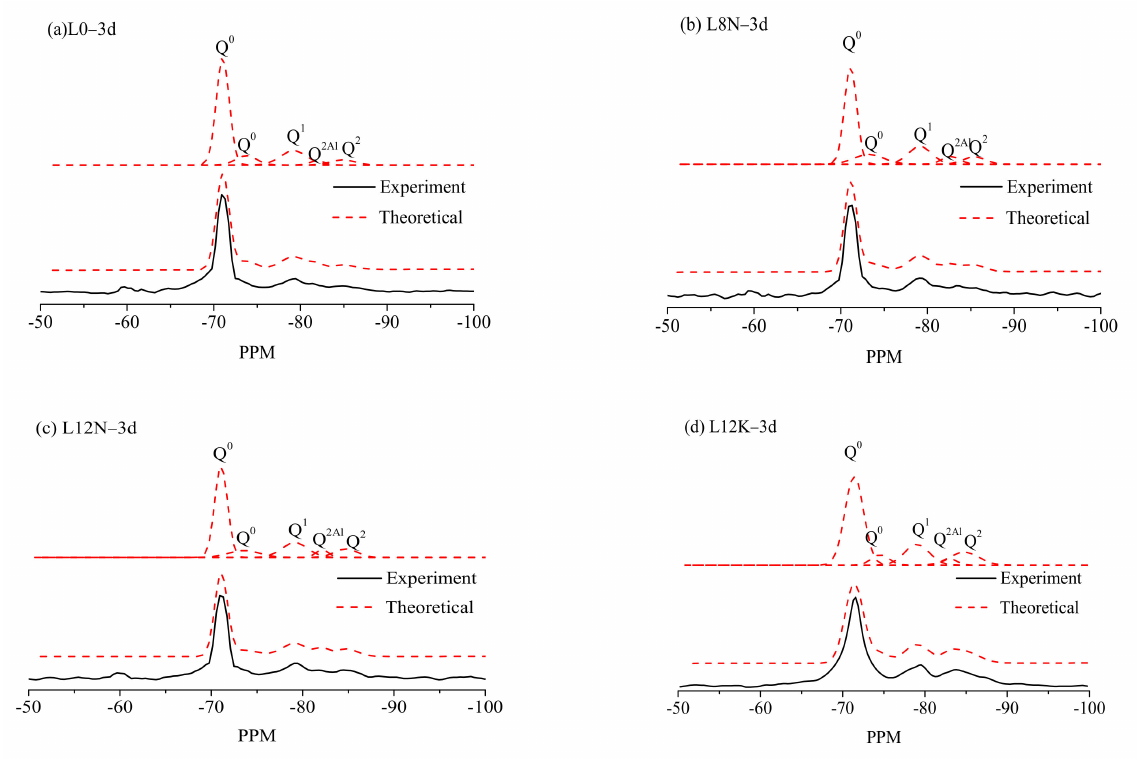
Figure 16. 29 Si MAS NMR curves of cement pastes with different contents and different types of alkali sulfates at 3d. ( a ) LHPC pastes with alkali content of 0.4% at 3d; ( b ) LHPC pastes with alkali content of 0.8% (added with Na 2 SO 4 ) at 3d; ( c ) LHPC pastes with alkali content of 1.2% (added with Na 2 SO 4 ) at 3d; ( d ) LHPC pastes with alkali content of 1.2% (added with K 2 SO 4 ) at